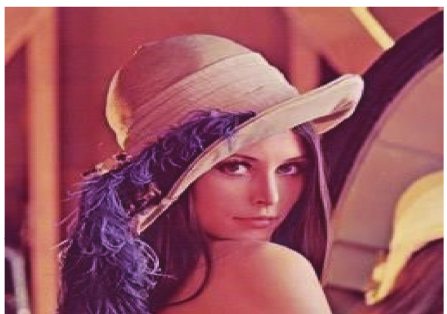
Figure 9: The experimental test image.